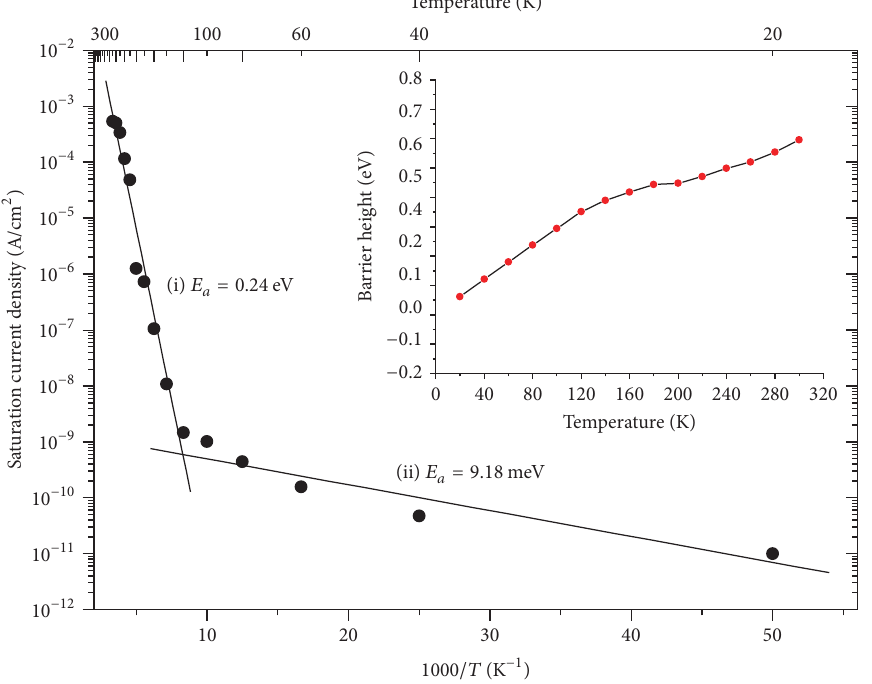
−2.0−1.0−0.51.02.0 −1.51.5 0.0